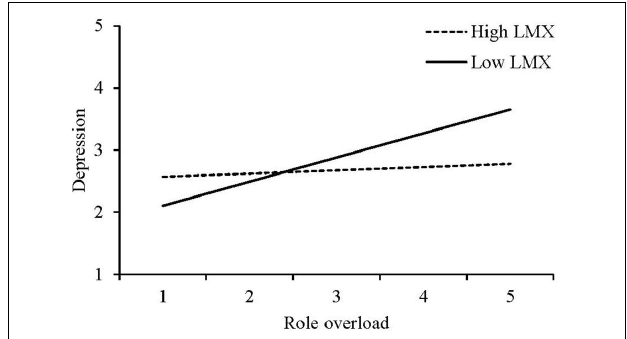
FIGURE 2 | Study 1 Moderating Effect of LMX on the Relationship Between Role Overload and